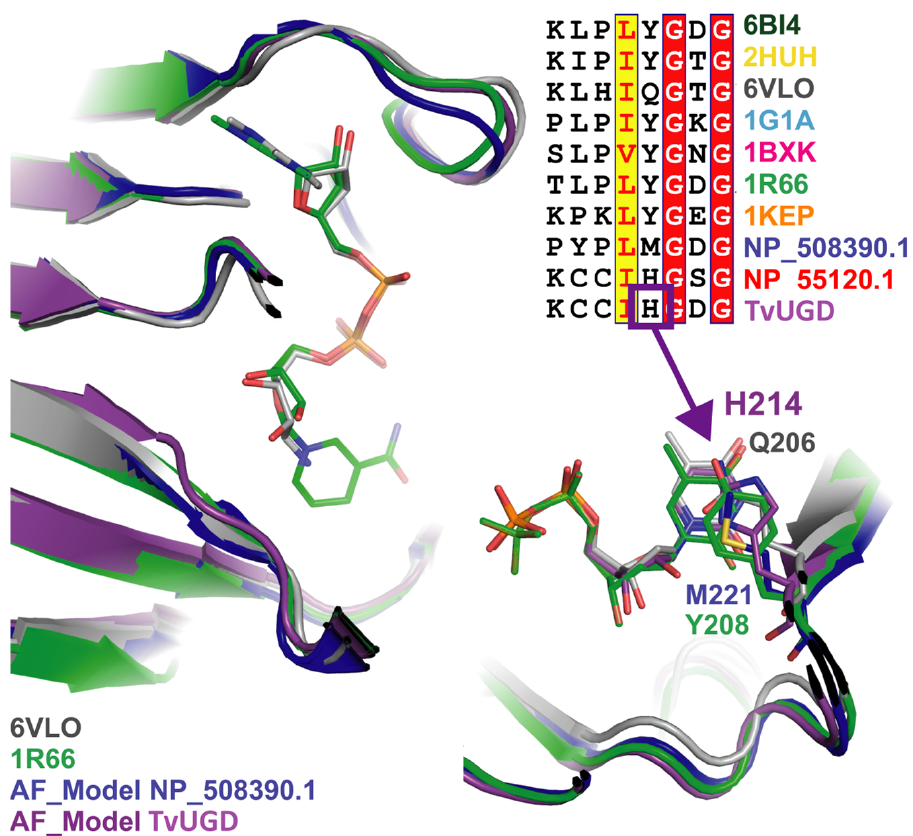
Figure 4. Close-up view of the 3D alignment of the NDP-D-Glc 4,6-dehydratase active site. The residues in the same position of TvUGD His214 are shown in sticks; as Tyr is conserved in most of the structures, only the one from PDB:1R66 is shown. The inset represents a portion of sequence alignment comprising TvUG His214. Acanthamoeba polyphaga Mimivirus R141 (PDB:6VLO in grey), Salmonella enterica (PDB:1G1A in cyan), Escherichia coli (PDB:1BXK in magenta), Streptomyces venezuelae (PDB:1R66 in green), Streptococcus suis (PDB:1KEP in orange), Homo sapiens , NP_508390 (AlphaFold2 model in blue), CELE_F53B1.4 from Caenorhabditis elegans , NP_055120 (AlphaFold2 model in red), model of TvUGD, TVAG_414560 (Alphafold2 model in violet).